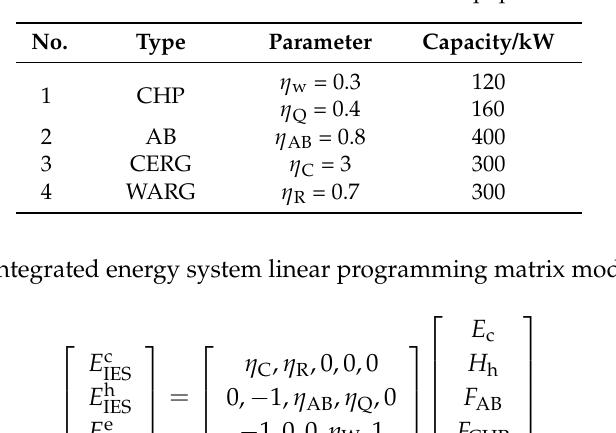
Table 4. Conversion characteristics of each equipment.